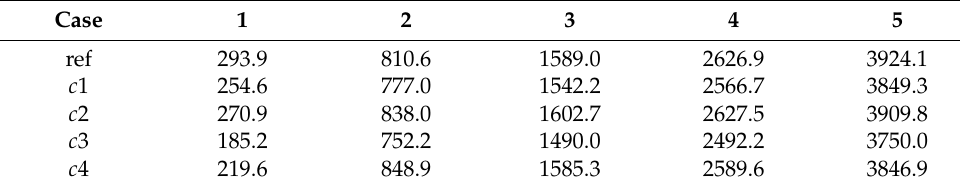
Table 9. The first five-mode frequencies under different combined loads